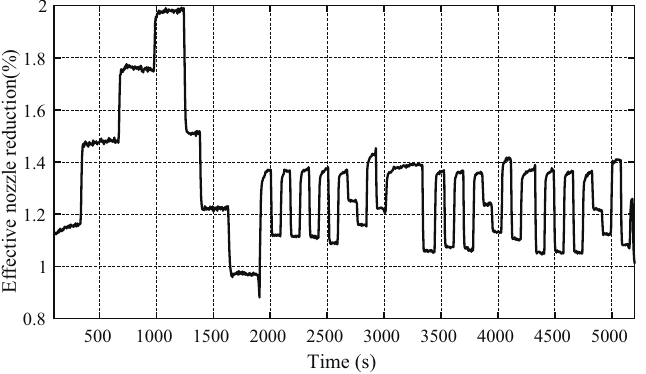
Figure 21. Effective nozzle area reduction when operating at different thermal